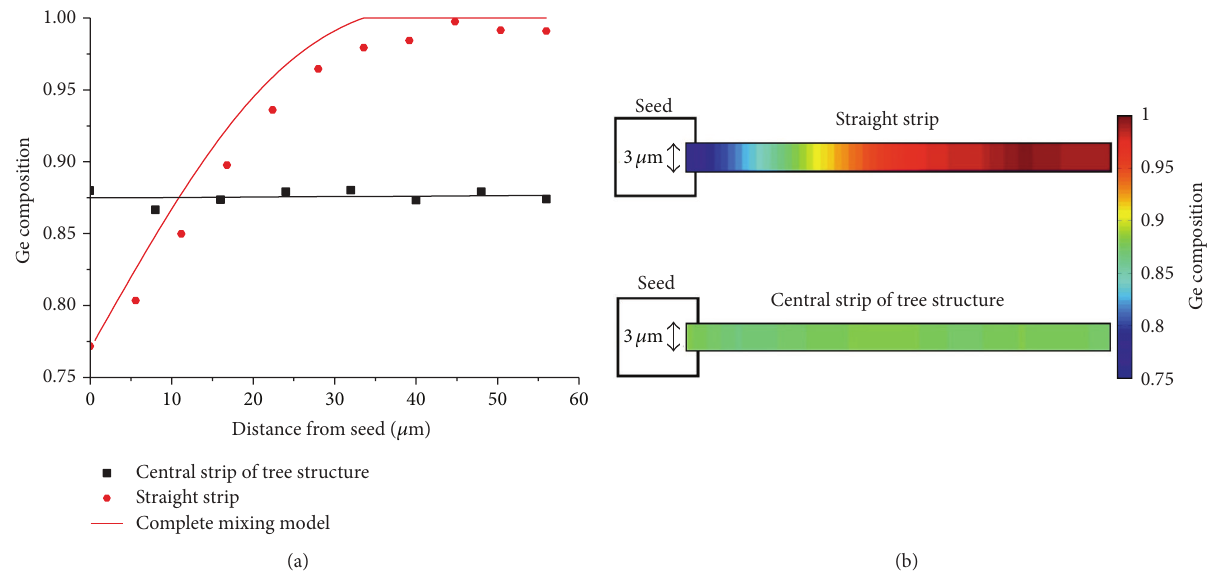
Figure 11: Comparison of SiGe composition profiles of the central strip of a tailored tree-like structure and a straight strip. (a) Graph and (b) schematic. The final set of branches have been omitted from the central strip of the tailored tree-like structure to display only the uniform composition region. The straight strip data has been normalised from Figure 4 to match the length of the tailored tree-like structure. The complete mixing model has been fitted to the straight strip data [33]. A linear fit has been added to the tailored tree-like structure data.